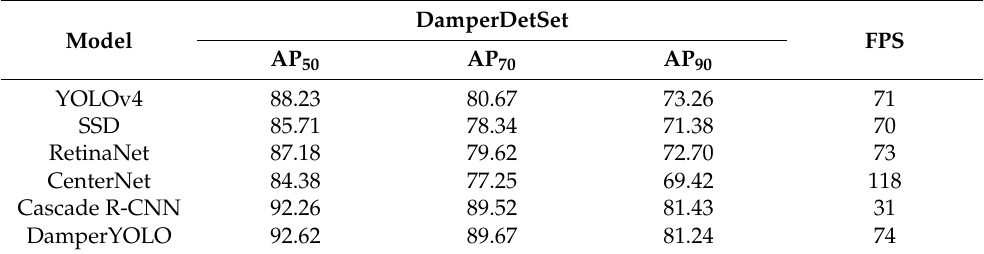
Table 2. APs of the different models.